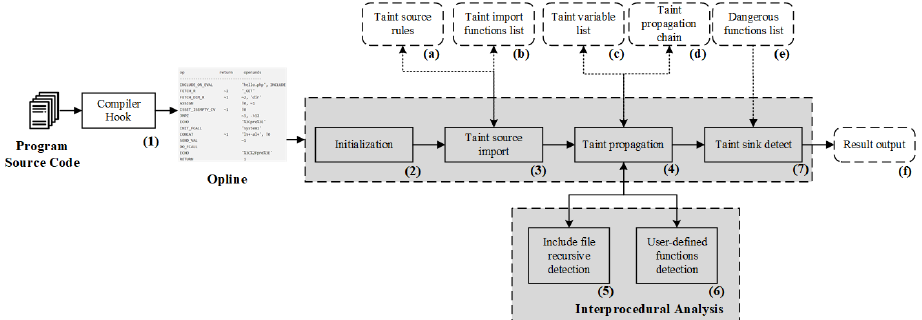
Figure 2. The overview of our